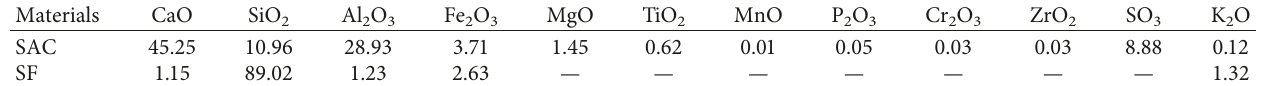
Table 1: Chemical composition of sulfoaluminate cement and silica fume (by weight percentage).